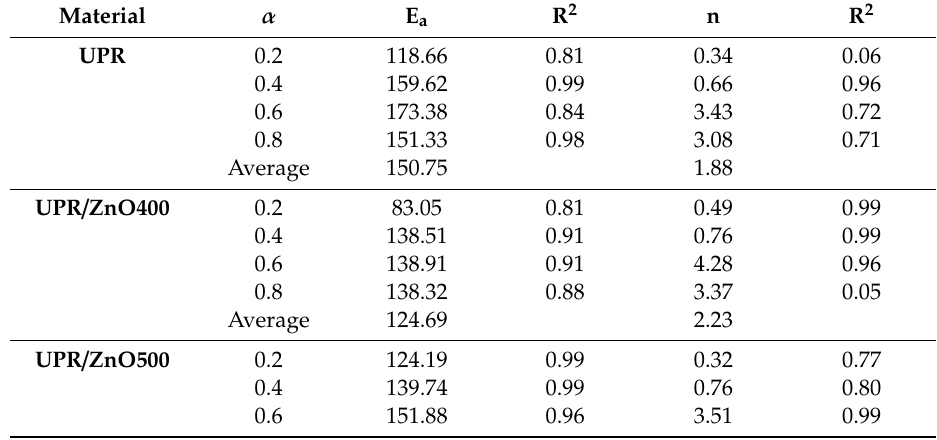
Figure 8. ln(1- α ) versus 1000 / T plots for ( a ) UPR, ( b ) UPR / ZnO400, ( c ) UPR / ZnO500 and ( d ) UPR / ZnO600. Table 3. Kinetic parameters E a and n for different values of α , at the right of each parameter is the corresponding correlation coefficient R2 obtained from the data fit with the Friedman model.